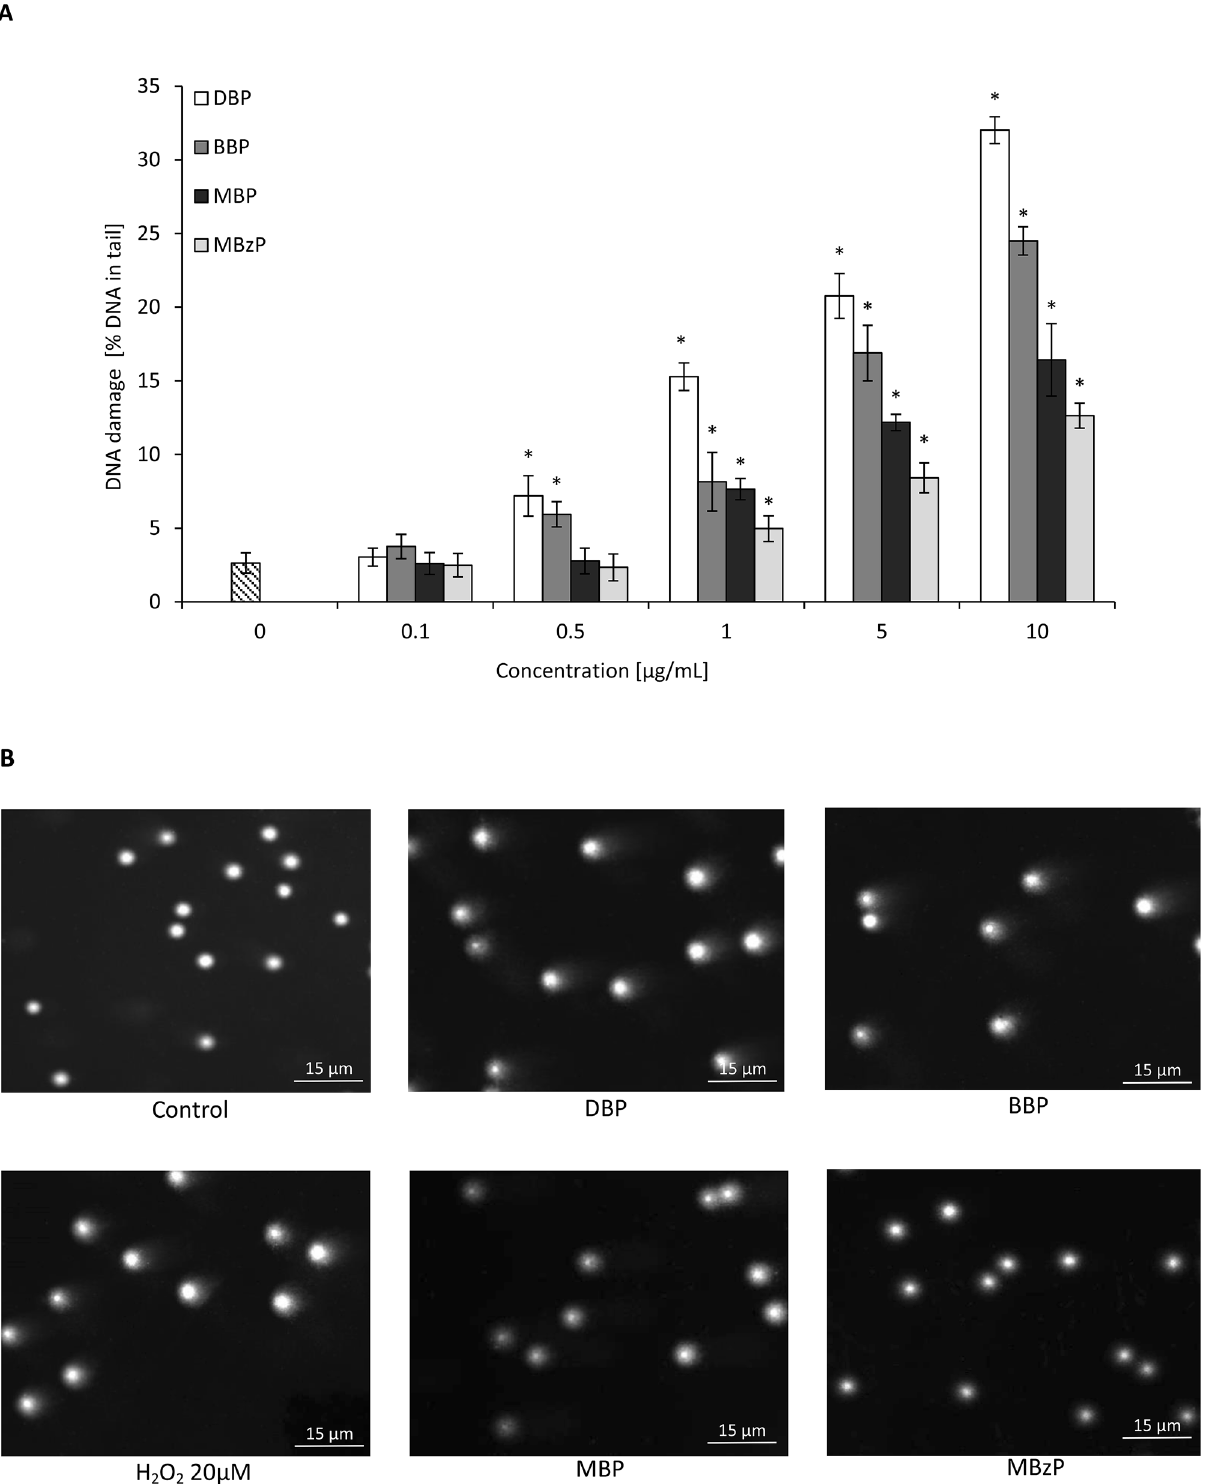
Figure 1. ( A ) The level of DNA strand-breaks in human PBMCs determined by single cell gel electrophoresis (Comet assay). DNA damage in PBMCs was induced by DBP, BBP, MBP and MBzP. The cells were incubated with the compounds examined in the concentrations range from 0.01 to 10 μg/mL for 24 h. DNA damage level was determined as tail intensity (percentage of DNA in comet’s tail) by alkaline version of the comet assay. (*) Statistically significant different from control (p<0.05). Each value represents the mean ± SD calculated from 5 individual experiments (5 blood donors). ( B ) Seleted photographs of DNA (comets) of human PBMCs incubated with phthalates in the concentration of 10 μg/mL for 24 h and hydrogen peroxide (20 μM) for 15 min on ice (positive control) (comet assay, alkaline version). The photos were achieved using fluorescent microscope with 200×